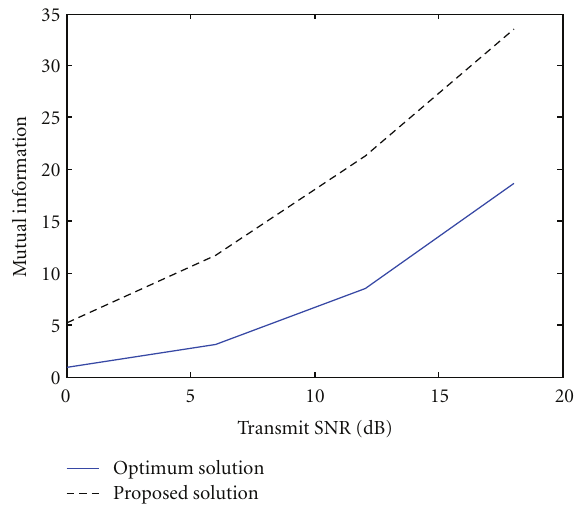
Figure 4: Eight-antenna example. Mutual information for the optimum precoder and the proposed precoder.